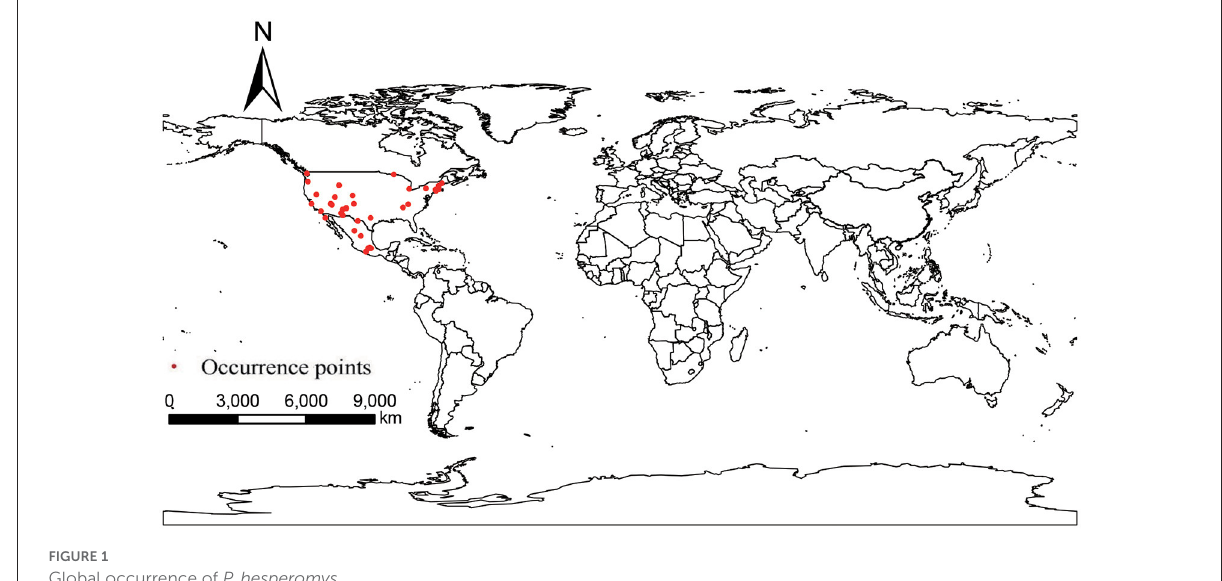
FIGURE1 Global occurrence of P. hesperomys .